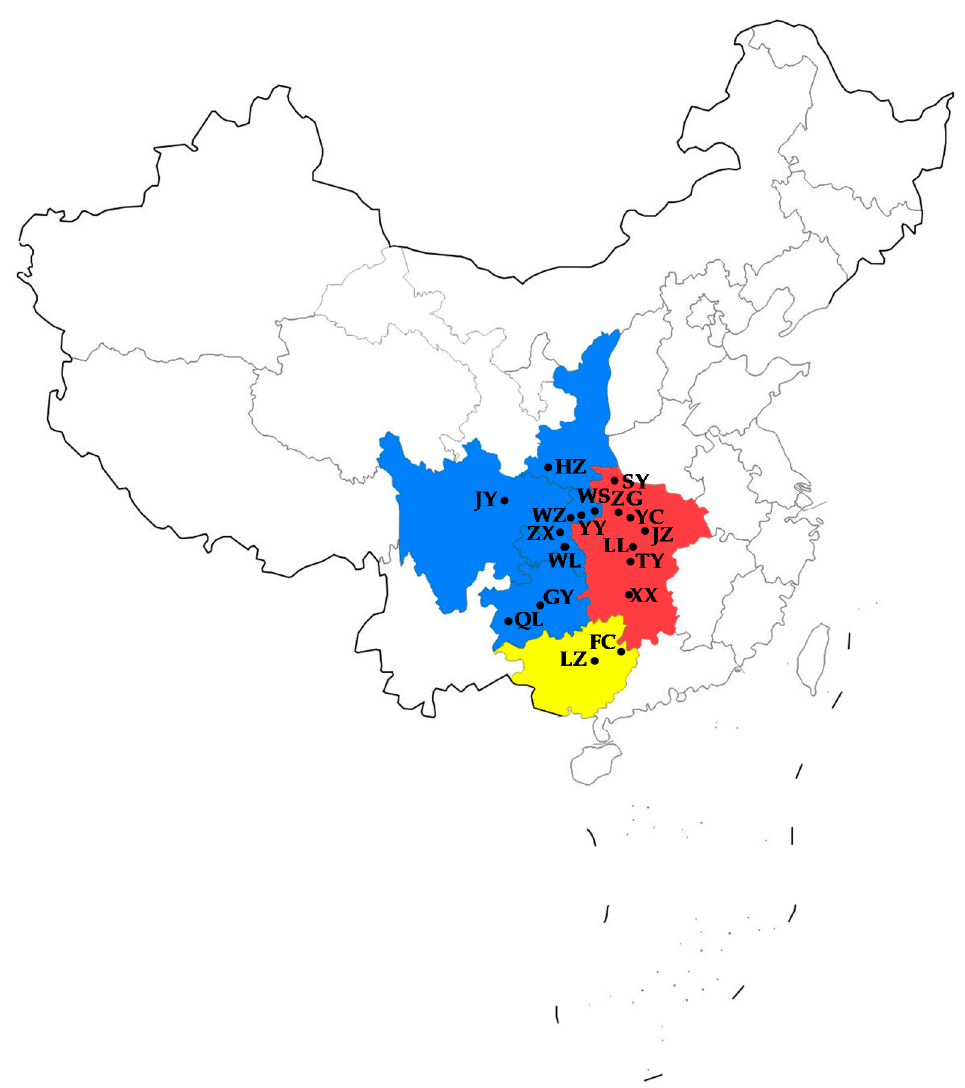
Figure 1. Sample collection sites of Bactrocera minax in China. Blue, Western China; Red, Central China; Yellow, Southern China.